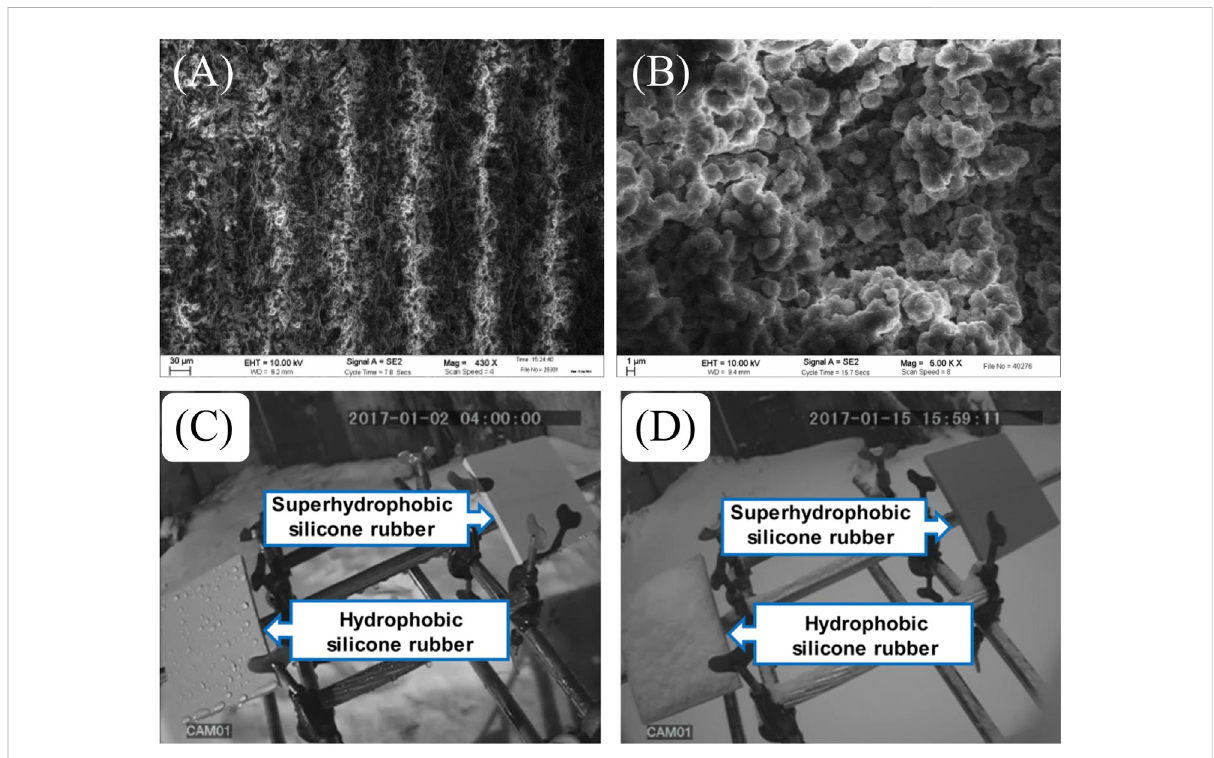
FIGURE 9 The SEM images of the laser-textured surface of silicone rubber at (A) 30 μ m and (B) 1 μ m (Emelyanenko et al., 2017). Behavior of hydrophobic silicone rubber and superhydrophobic silicone rubber during rain (C) and during snow (D) (Emelyanenko et al.,